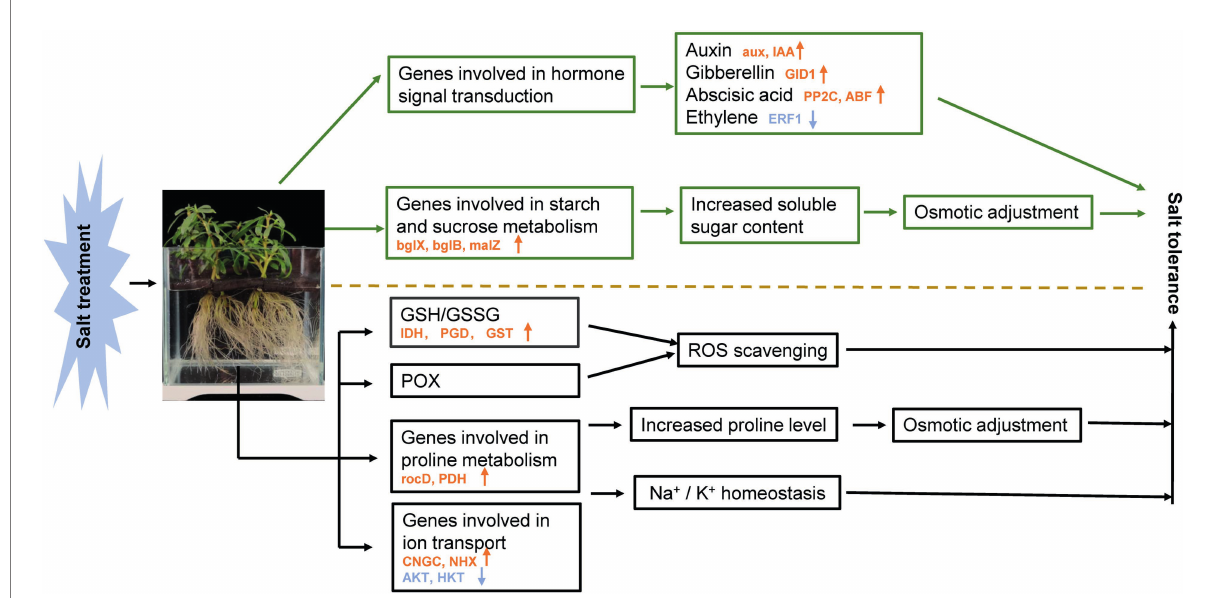
FIGURE 10 Schematic presentation of the potential mechanism of salt stress tolerance in S. portulacastrum. The yellow arrows in the figure represent the increased expression of related genes. Blue arrows represent decreased gene expression. The mentioned genes were selected from plants after 1 h of Na